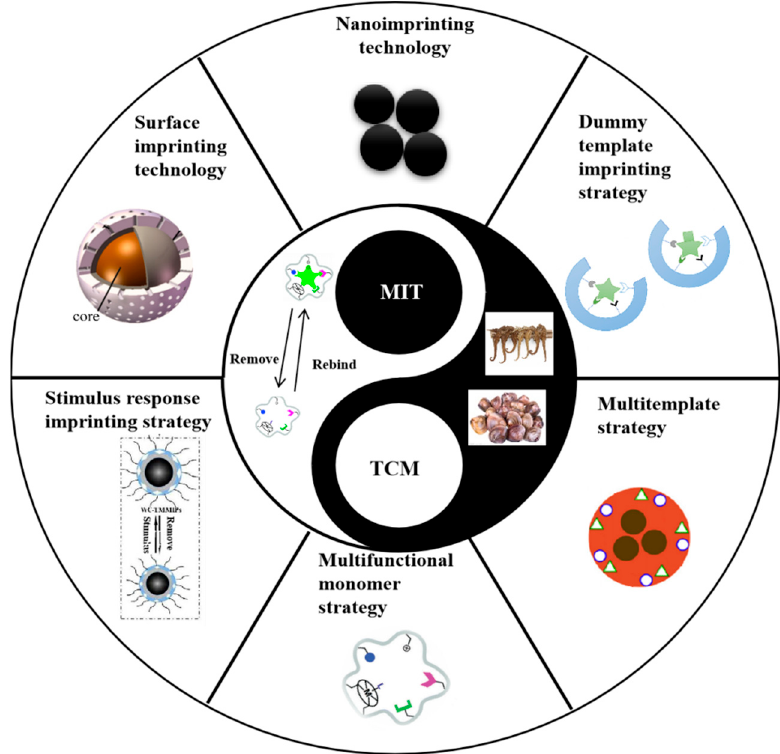
Figure 1. New imprinting technologies and strategies for preparing TCM-related MIPs [23,43].